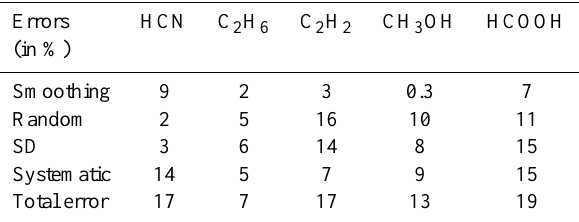
Table 2. Mean error budget on individual total columns. The mean standard deviations (SD) of daily means, for the days when the number of measurements were equal or greater than three, are also given. The total error includes the smoothing